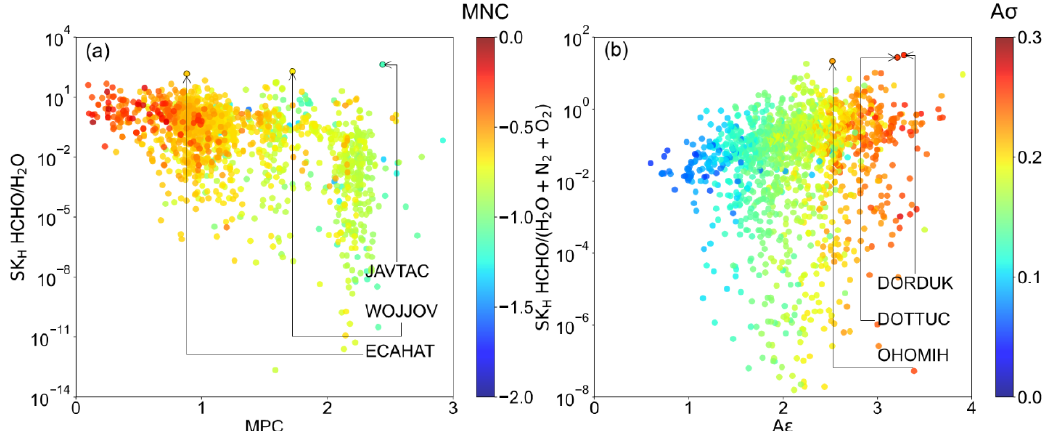
Figure 6. The relationship between chemical descriptors and Henry’s constant selectivity. ( a ) MPC and SK H HCHO/H 2 O, colored by the MNC; ( b ) A ε and SK H HCHO/(H 2 O + N 2 + O 2 ), colored by the A σ .